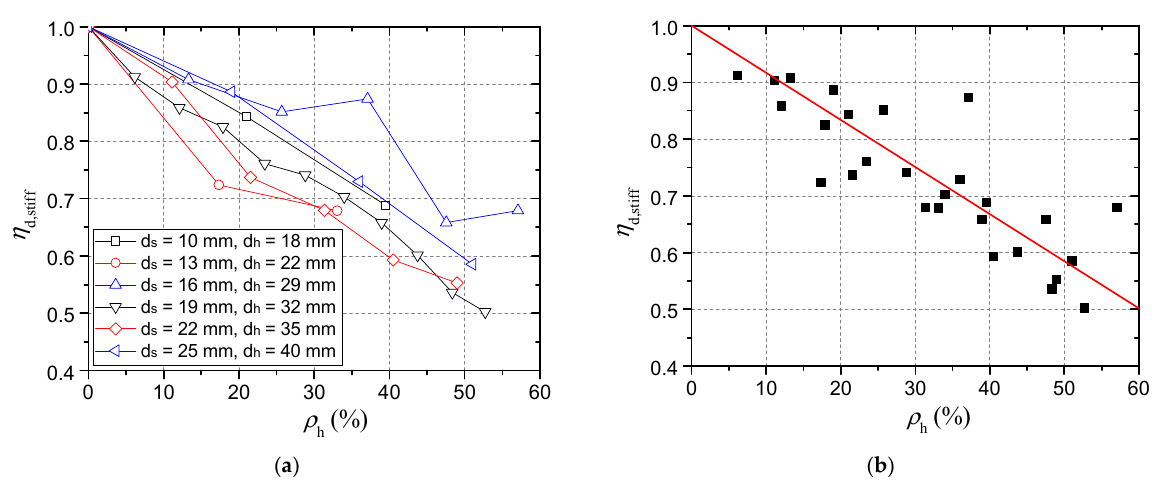
Figure 22. Stiffness results of damaged connectors of different sizes and different damage degrees: ( a ) Stiffness reduction factor; ( b ) Proposed formula of stiffness reduction factor.